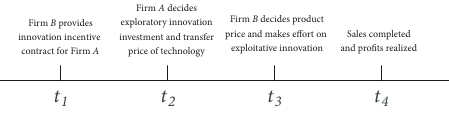
Figure 1: Decision-making